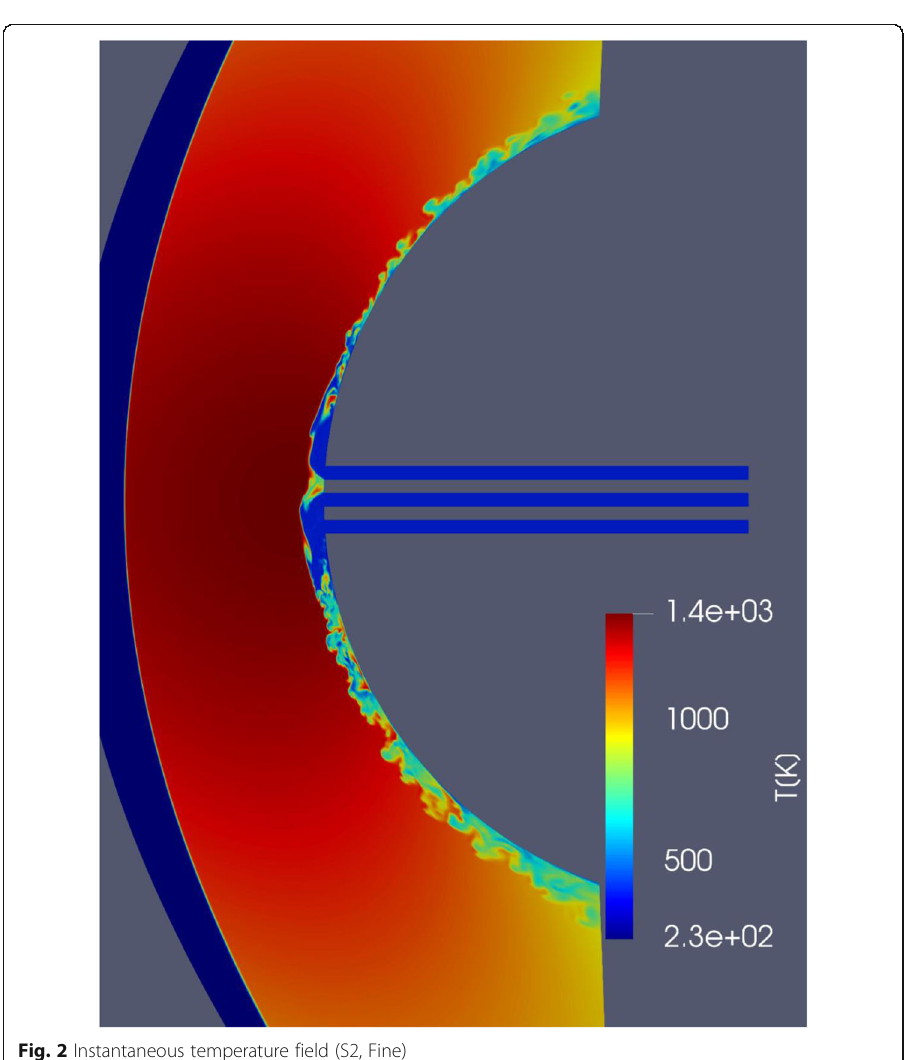
Fig. 2 Instantaneous temperature field (S2,